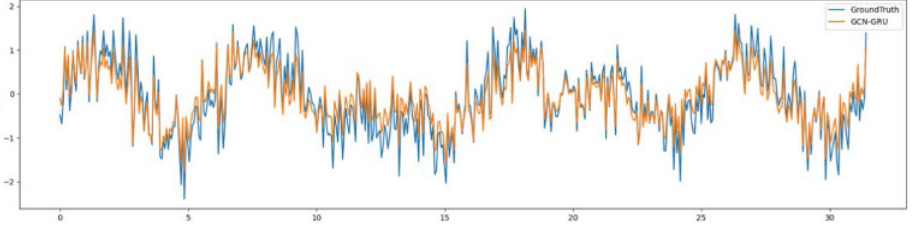
Fig. 1. Temporal dependence, the sensor parameters on Sensor 1 shows a periodic change over 30 minutes.